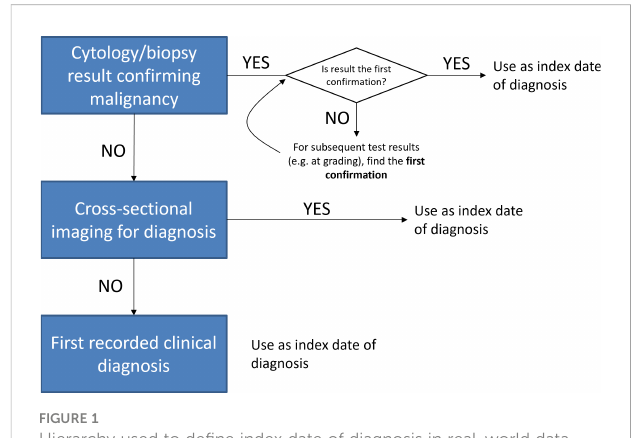
FIGURE 1 Hierarchy used to de fi ne index date of diagnosis in real-world data across study